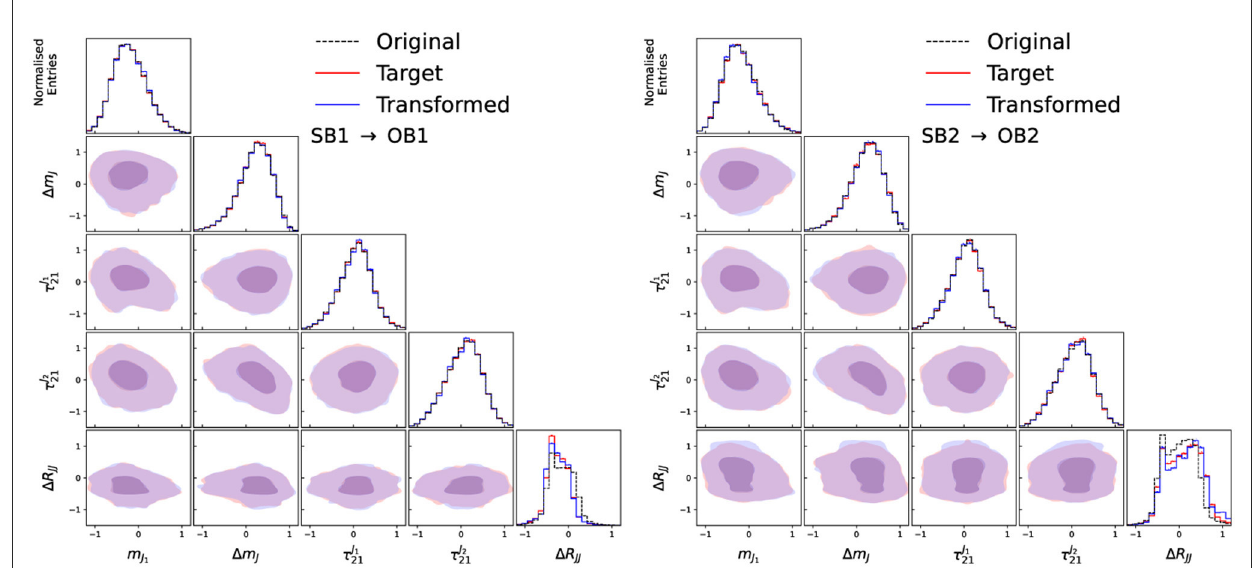
FIGURE4 Input, target, and transformed data distributions for the base variable set with the addition of 1 R JJ , for transforming data from SB1 to OB1 (left) and SB2 to OB2 (right) , with the model trained on SB1